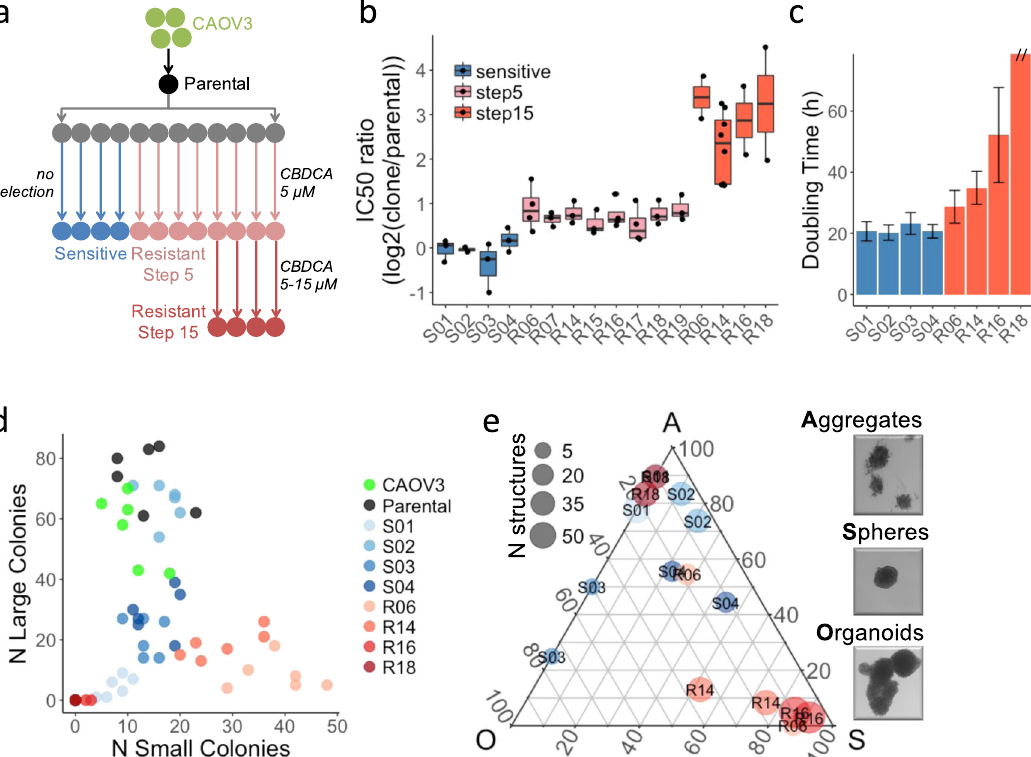
Fig. 1 Phenotypic characterization of the resistant clones. a Schematic representation of the work fl ow to generate CBDCA resistant clones from CAOV3. b Changes in IC50 of S clones (unselected) or R clones (8 at step 5 and 4 at step 15). Each IC50 is calculated from dose-response curves of 6 replicates and experiments repeated twice or more (dots). Boxes represent the top and bottom quartiles of the distribution and whiskers are extended to 1.5 time the interquartile range. c Doubling time measured over a 48 h time course — y axis cut for R18 (>100 h). d Counting of colonies formed in a period of 9 days after seeding 200 cells per well. Experimental replicates ( N = 6) are shown. e Fraction of organoids (O), spheres (S) and cell aggregates (A) observed after 14 days growth in low adherence 3D culture model. For each sample ( N = 8) and replicates ( N = 2), the total number (point size) and relative abundance (Gibbs triangle coordinates) of each type of structure are